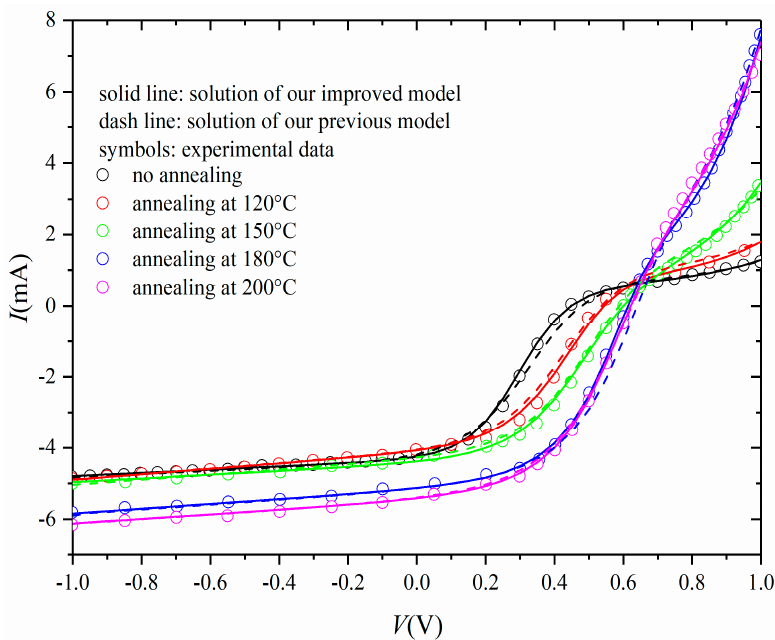
Figure 10. Comparisons between simulation results of our improved circuit with our previous circuit